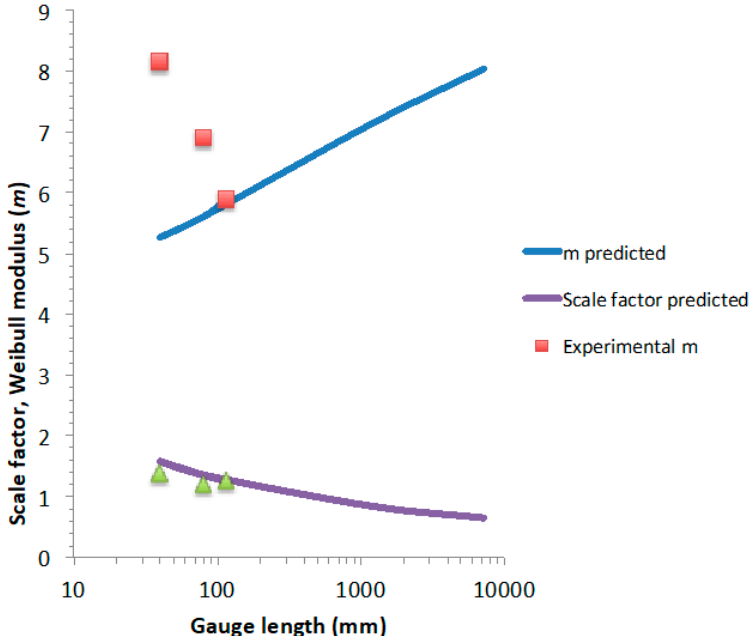
Figure 9. Predictions from 115 mm quantile diagram: Weibull modulus and scale factor values derived from the p-quantile diagrams predicted for various gauge lengths.